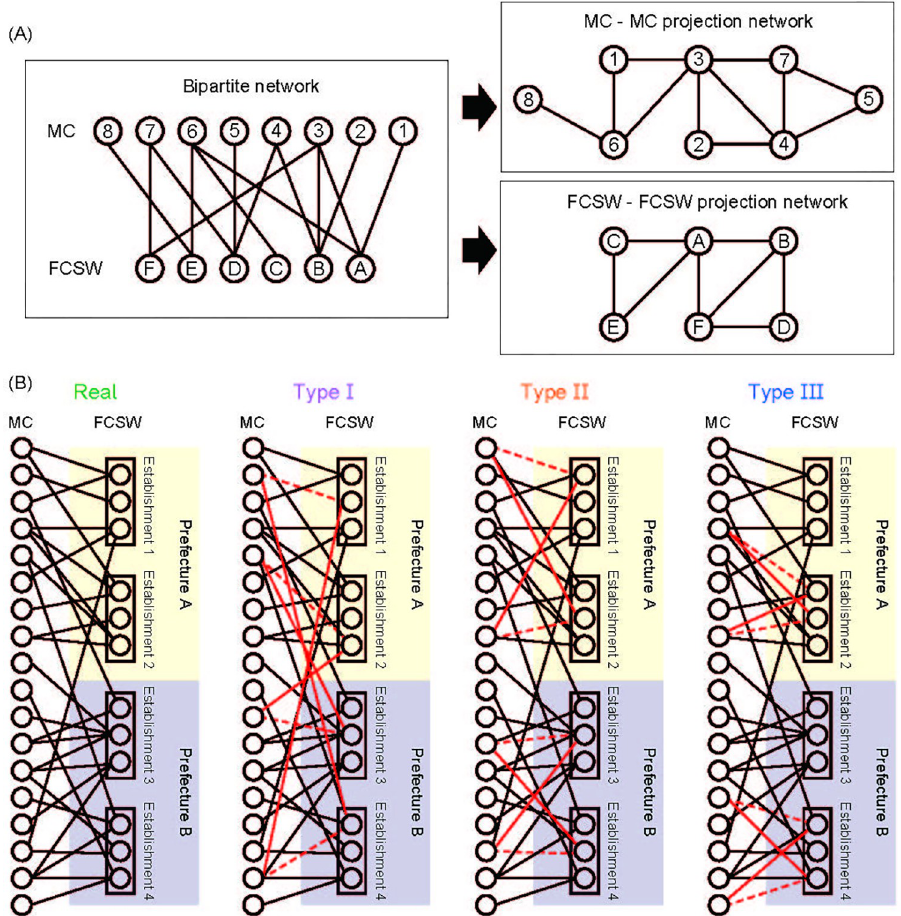
Fig 2. Bipartite network and projection networks; artificially generated networks; average path length and bipartite clustering coefficient. (A) Bipartite network of FCSWs and MCs. A link implies that there is at least one review between the FCSW and MC. For the MC–MC projection network, a link implies that the two MCs reviewed at least one common FCSW. For the FCSW–FCSW projection network, a link implies that two FCSWs were reviewed by at least one common MC. (B) For comparison, we used three types of artificially generated networks. For each case, we generated 100 networks where a sufficient number of links were